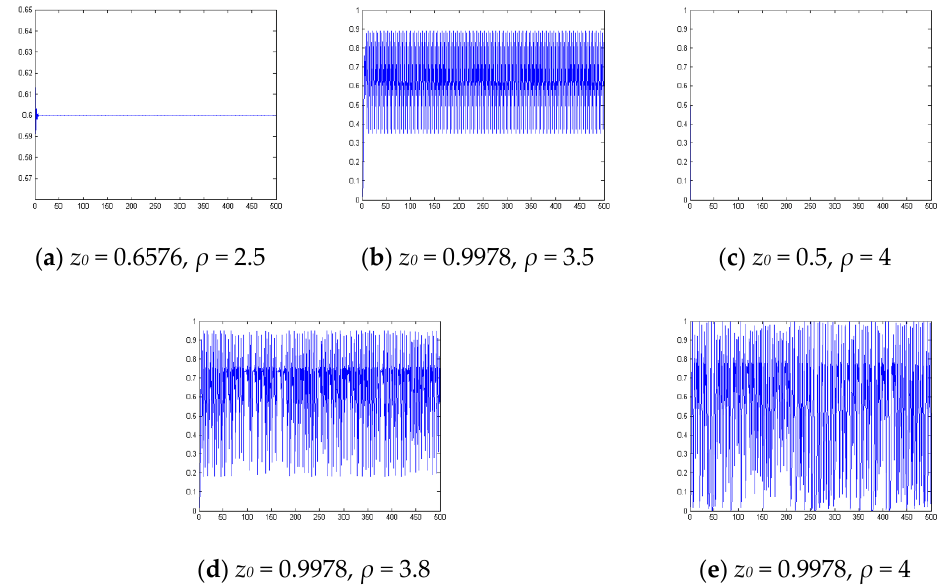
Figure 4. The trajectory sequence distribution diagrams of five combinations of initial values and parameters. With the initial value z 0 = 0.9978 and ρ = 4, the Logistic chaotic mapping equation can form an averagely distributed chaotic sequence with good ergodicity, which can search space globally. Therefore, the initial value z 0 = 0.9978 and ρ = 4 are selected for chaotic model in the following